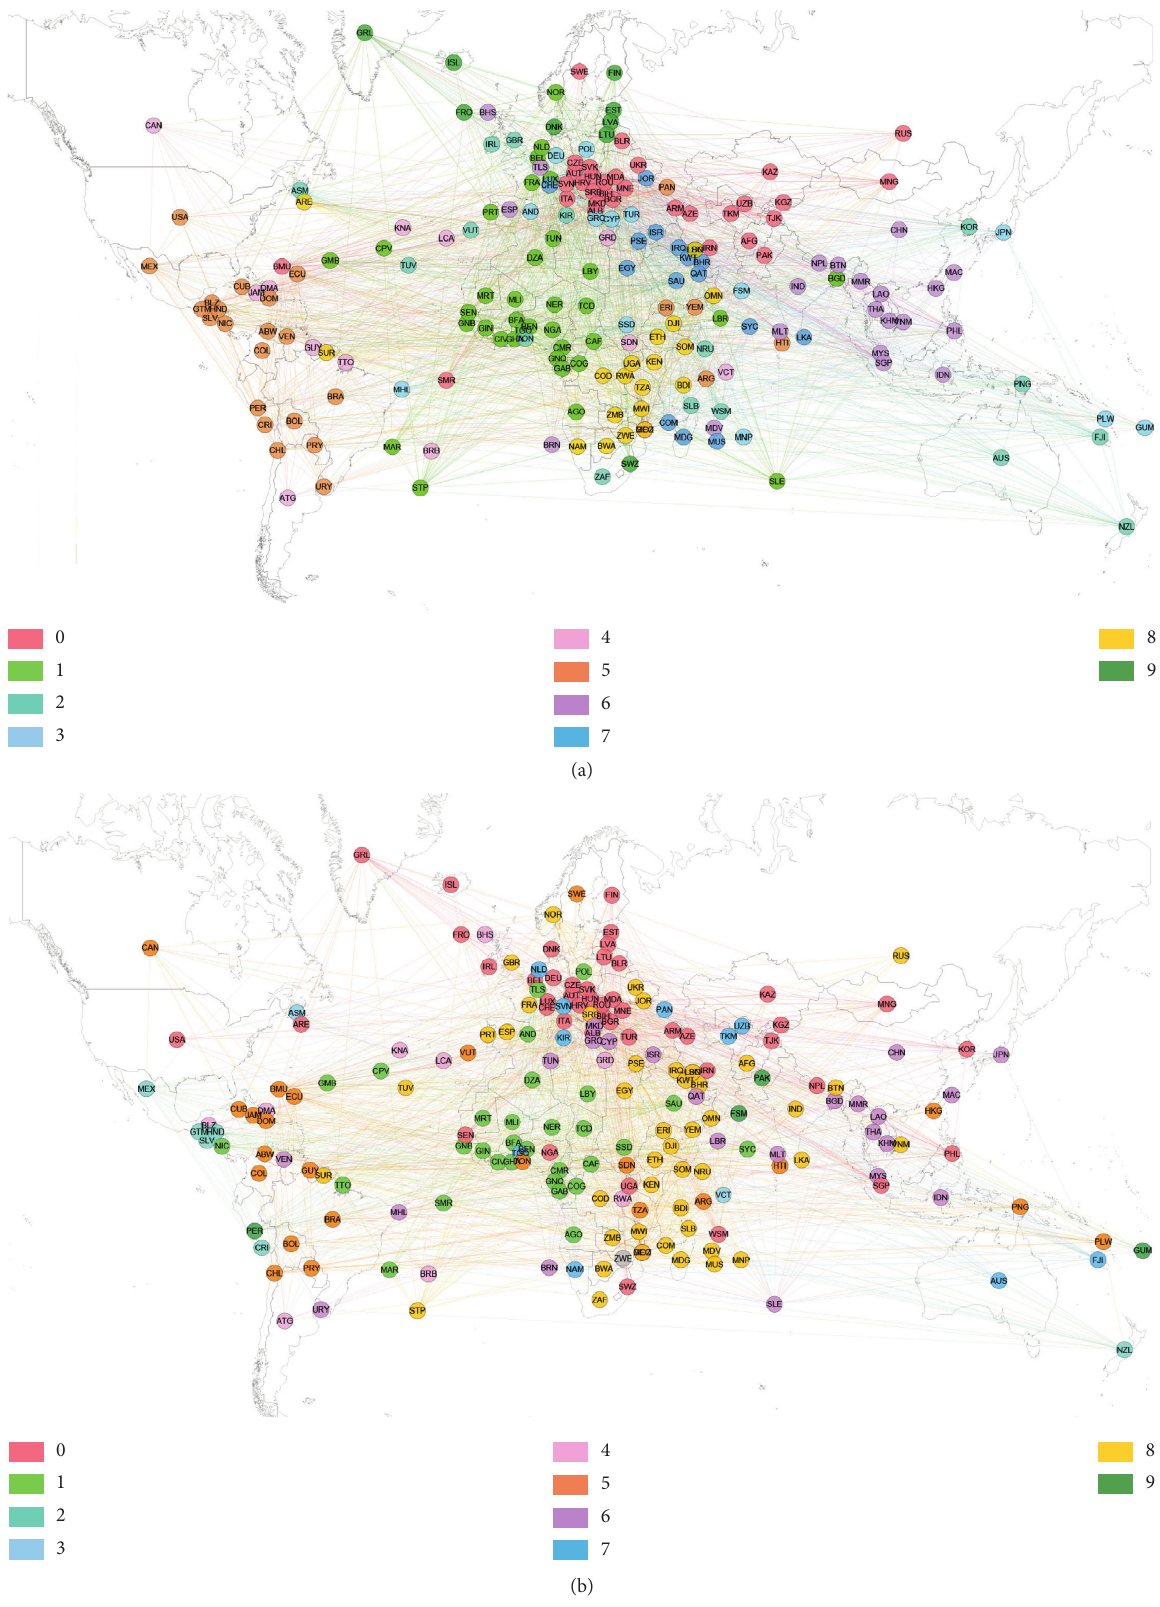
Figure 5: Communities in the global trade network in 2007 (a) and 2017